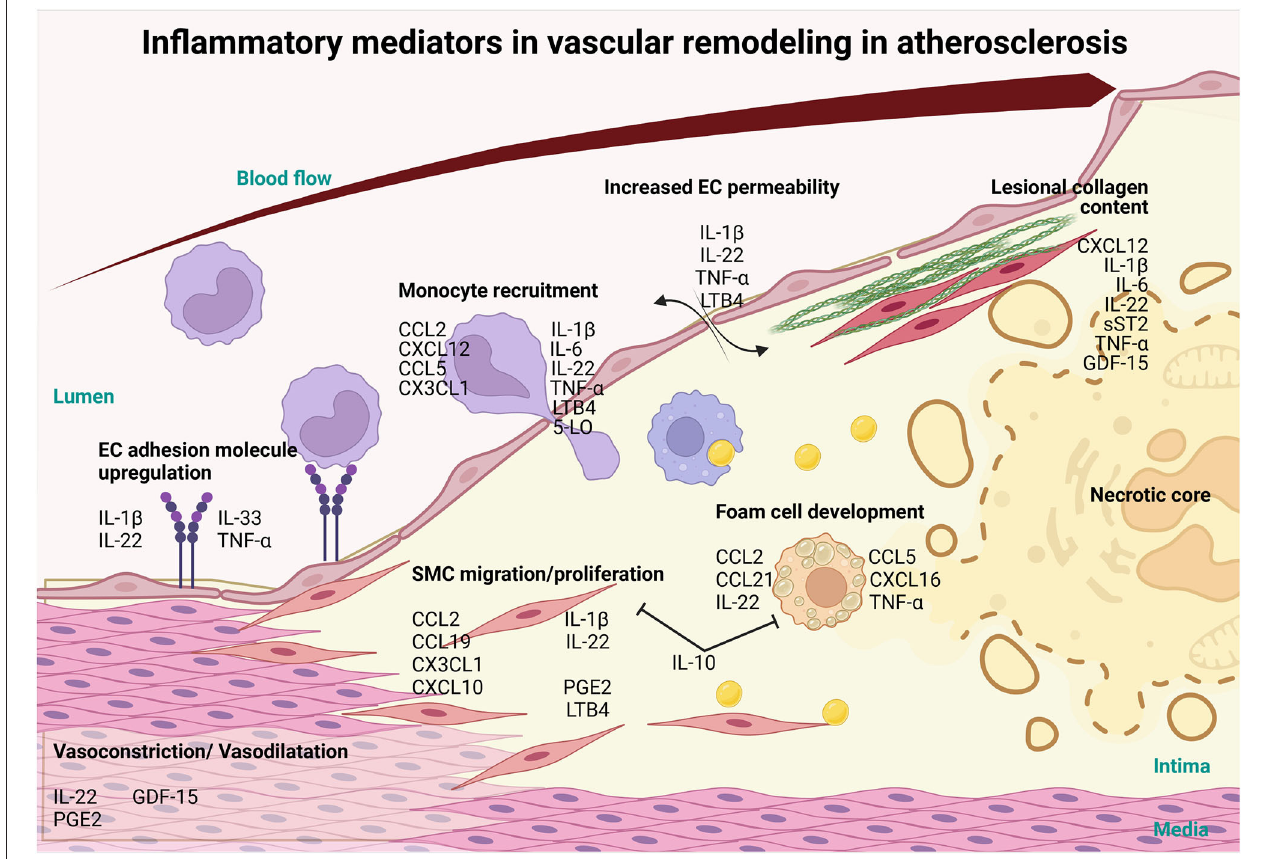
FIGURE 1 | Involvement of inflammatory mediators in vascular remodeling in atherosclerosis. Inflammatory mediators, such as interlukin-1 β (IL-1 β ), IL-22, IL-33 and tumor necrosis factor- α (TNF α ) cytokines can influence the progression of atherosclerosis and CVD via the activation of the endothelium resulting in the upregulation of adhesion molecules. Furthermore, these mediators increase vascular permeability, through IL-1 β , IL-22, TNF α and LTB4 and along with the adhesion molecule upregulation allows for the infiltration of monocytes and other immune cells recruited via chemokine ligand 2 (CCL2), C-X-C Motif Chemokine Ligand 12